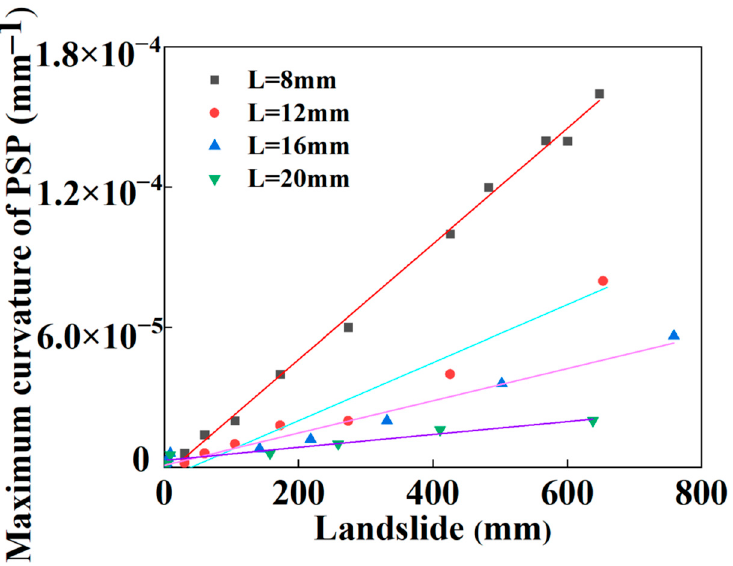
Figure 18. Influence of landslide on the maximum curvature of the SWW-RTP in soil with different landslide area widths.